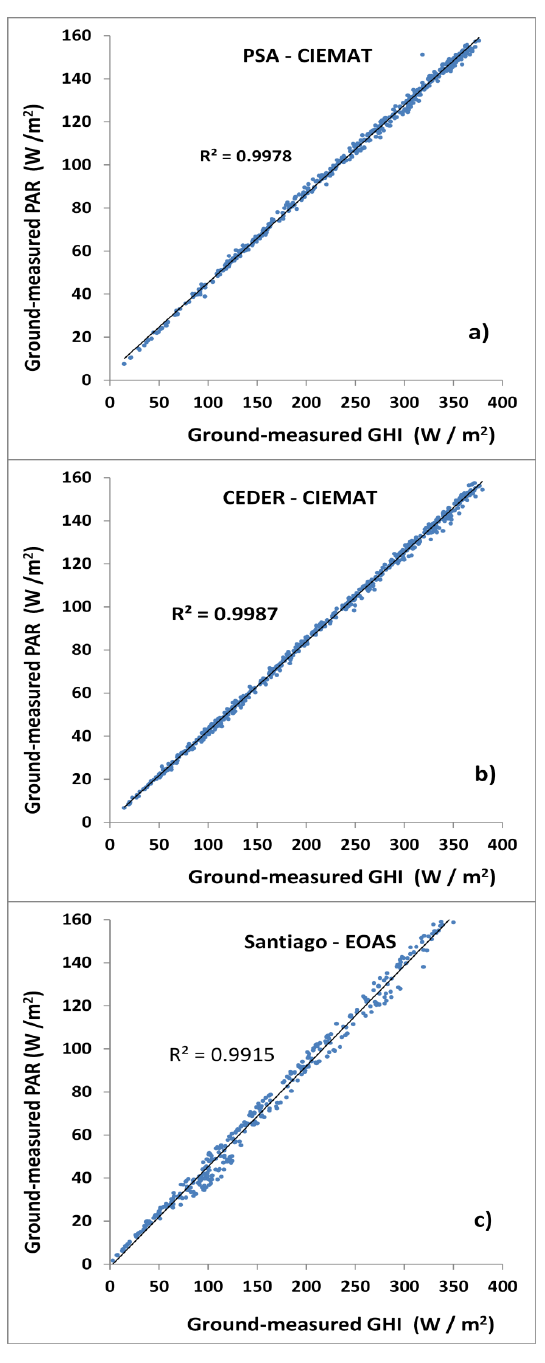
Figure 3. PAR measured versus GHI measured for validation stations: ( a – c ) correspond to PSA-CIEMAT, CEDER-CIEMAT, and Santiago-EOAS stations, respectively.